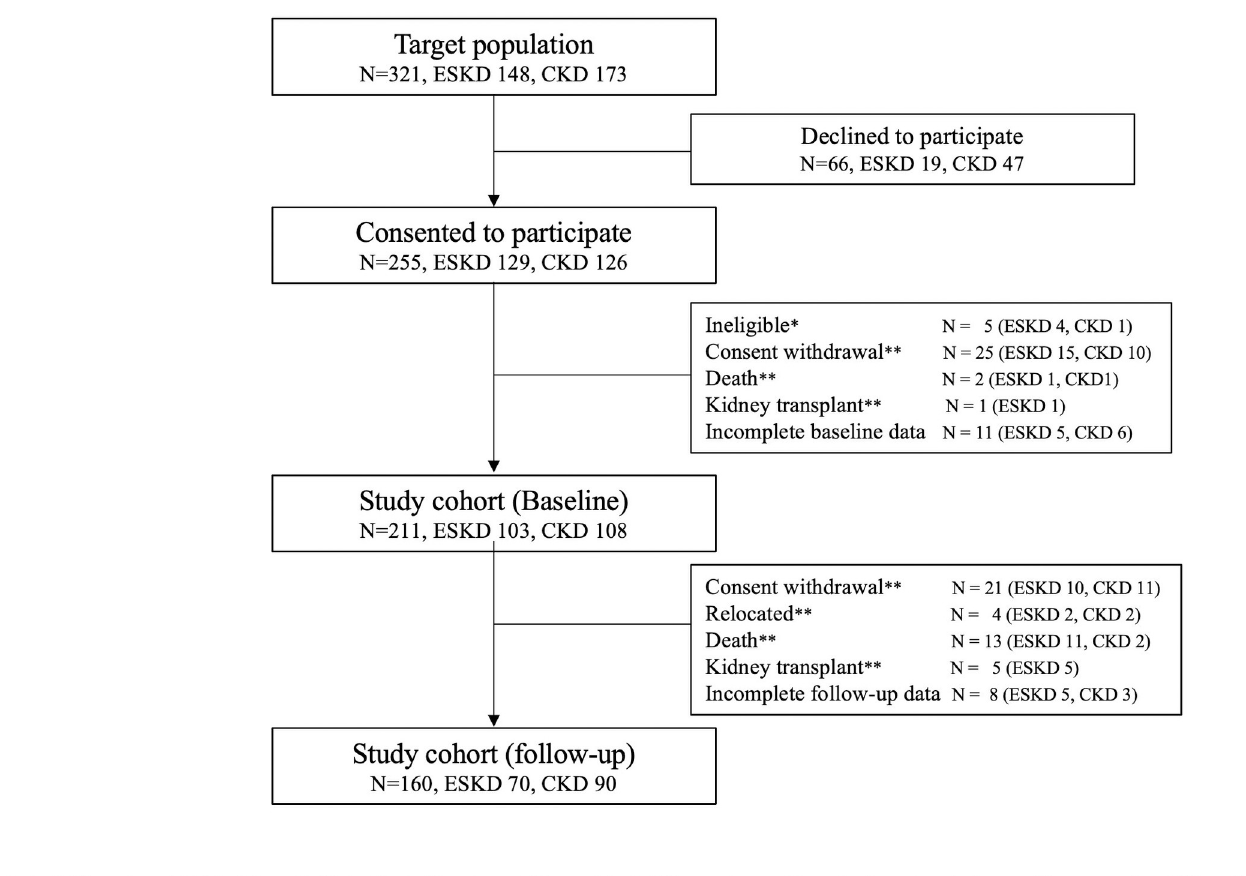
Fig 1. Flow chart of patient participation in the